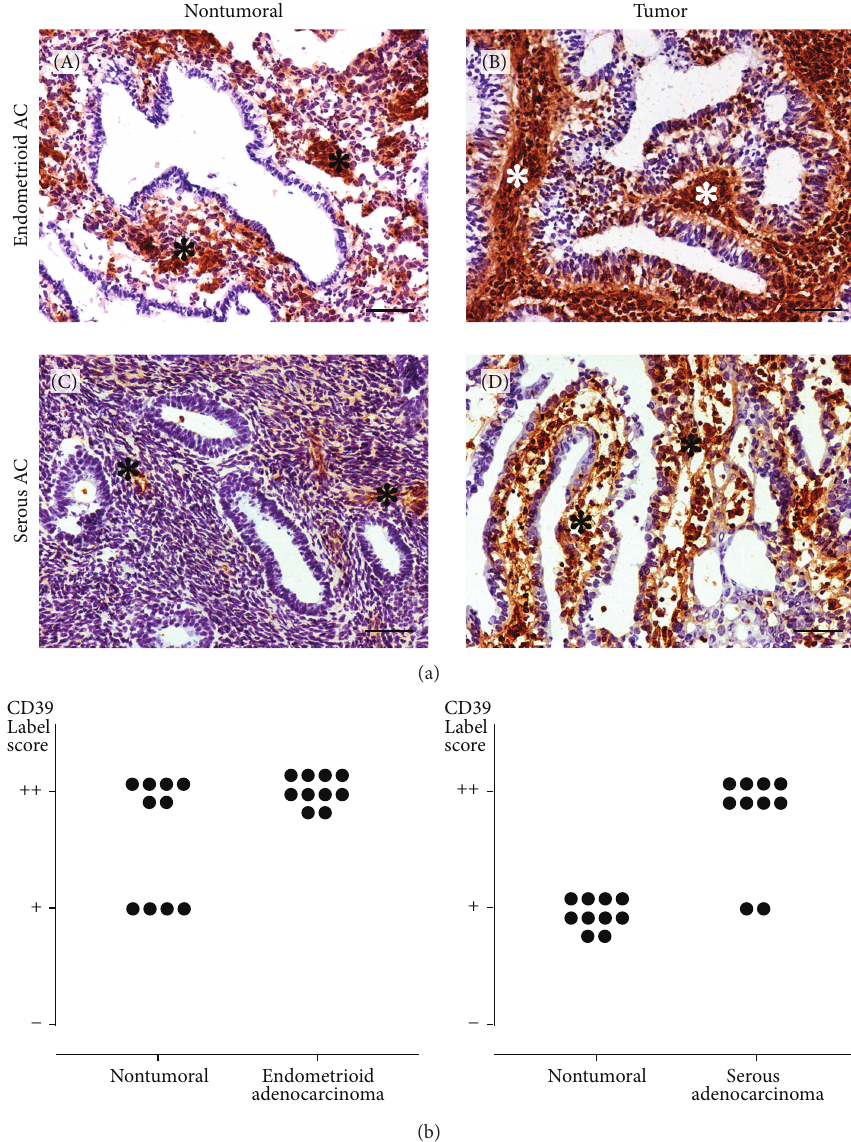
Figure 1: (a) Immunolocalization of NTPDase1/CD39 in nontumoral human endometria ((A), (C)) and in endometrioid (B) and serous (D) adenocarcinomas. CD39 was immunodetected in the stroma of all samples (asterisks). The expression of CD39 is remarkably higher in tumors when compared with nontumoral endometria. Scale bars = 100 𝜇 m. (b) Label intensity score of CD39 in the stroma of nontumoral human endometrium compared to endometrioid (left plot) and serous (right plot) adenocarcinoma samples. Note that both types of tumors have a higher label score than their corresponding nontumoral